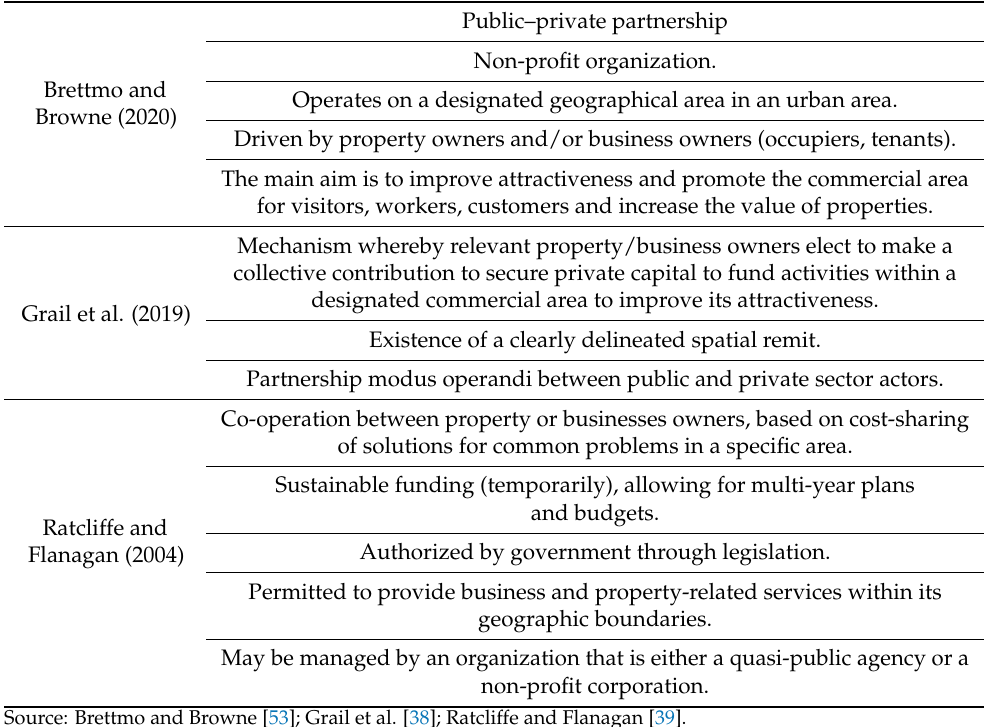
Table 1. Consensual characteristics regarding the establishment and execution of a BID.